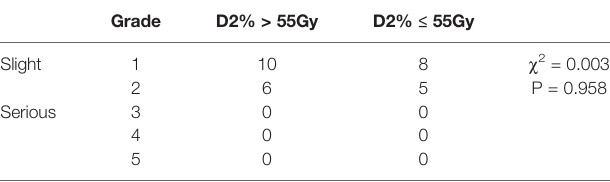
TABLE 2 | The incidence of RION.